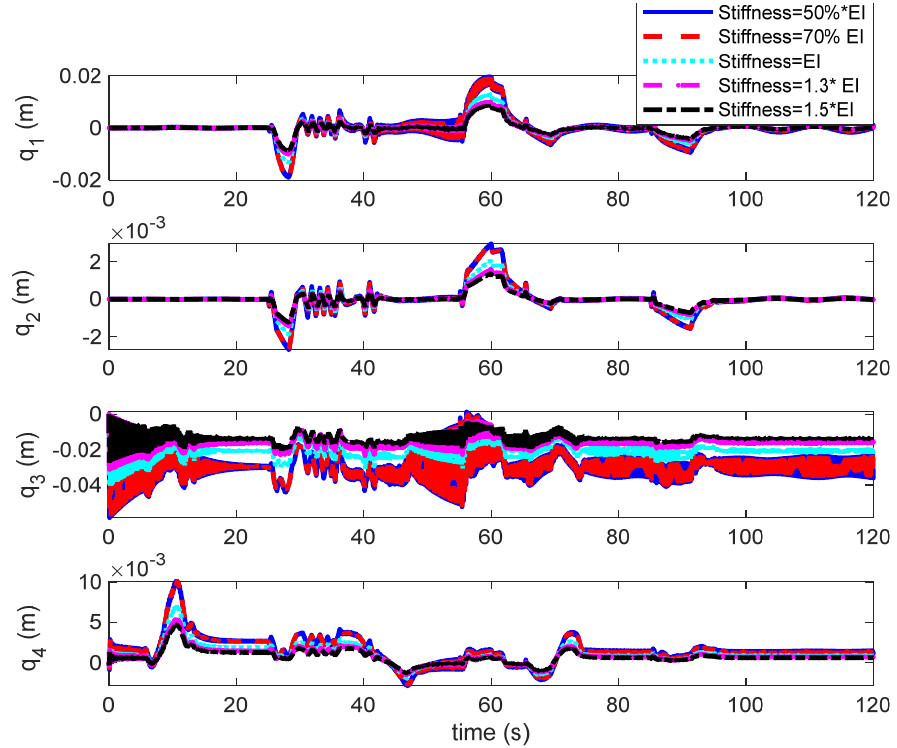
Figure 14. The generalized coordinate responses of structure modes.